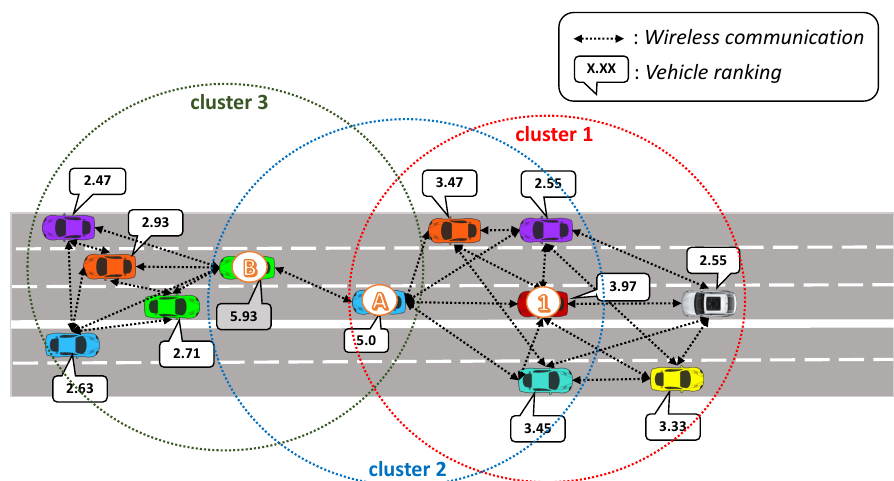
Figure 1. Example of clustering, the labels A and B represent the temporary CHs of groups 1 and